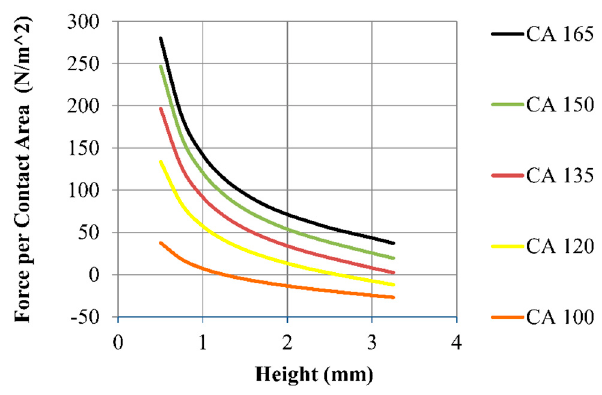
Figure 5. Force per unit area calculated from Equation (6). Each line indicates the different contact angles used for the top and bottom surfaces. The droplet’s volume was fixed at 50 µ L.